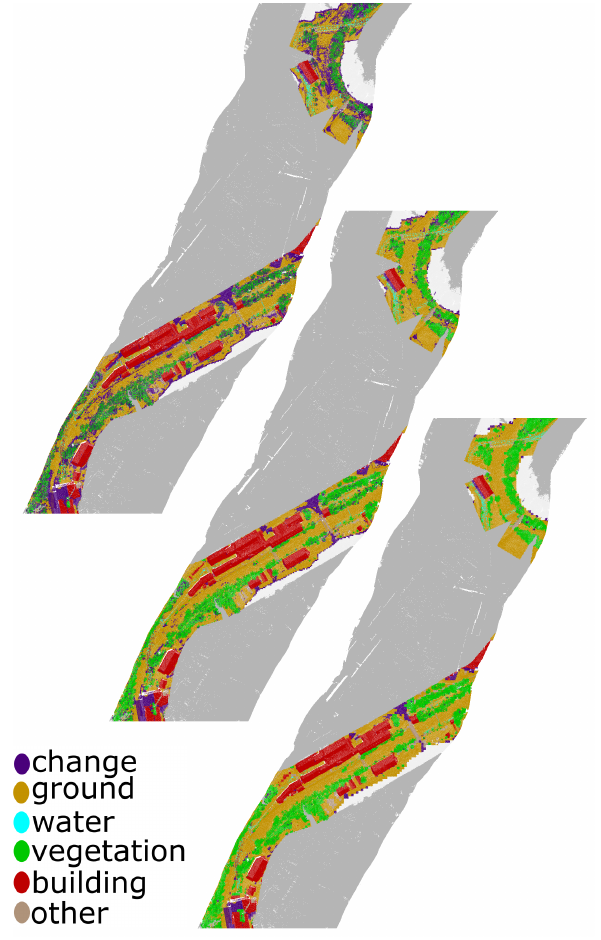
Figure 7. Result for assigning reference labels. Shown are the results of different voxel sizes, from top to down: 1 m, 2 m, 4 m. The Ground truth of the change labels can be seen in figure